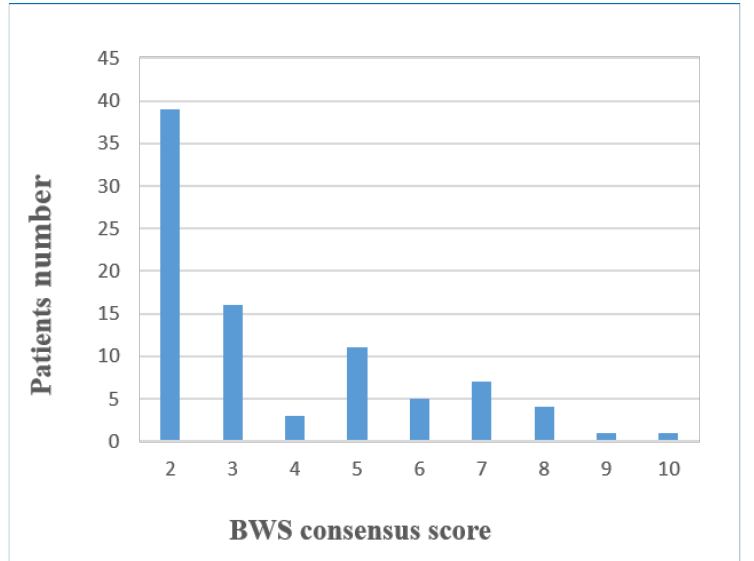
Figure 1. Distribution of patient numbers according to BWSp consensus score.